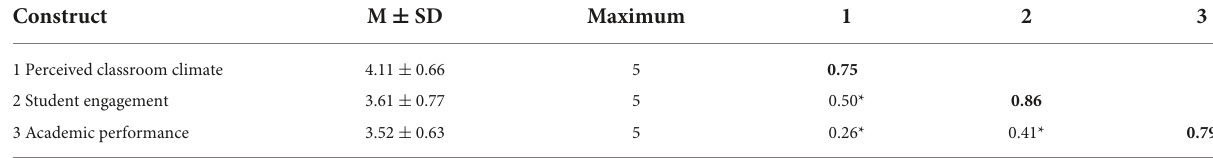
TABLE 2 Correlation coefficients and discriminant validity analysis.